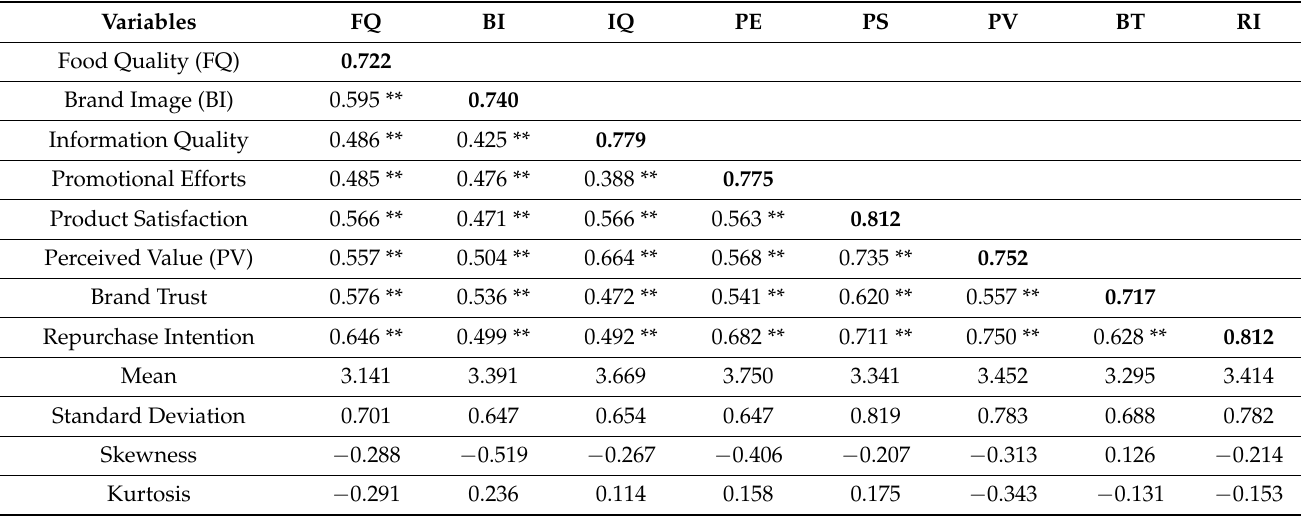
Table 3. Correlation of latent variables and square roots of